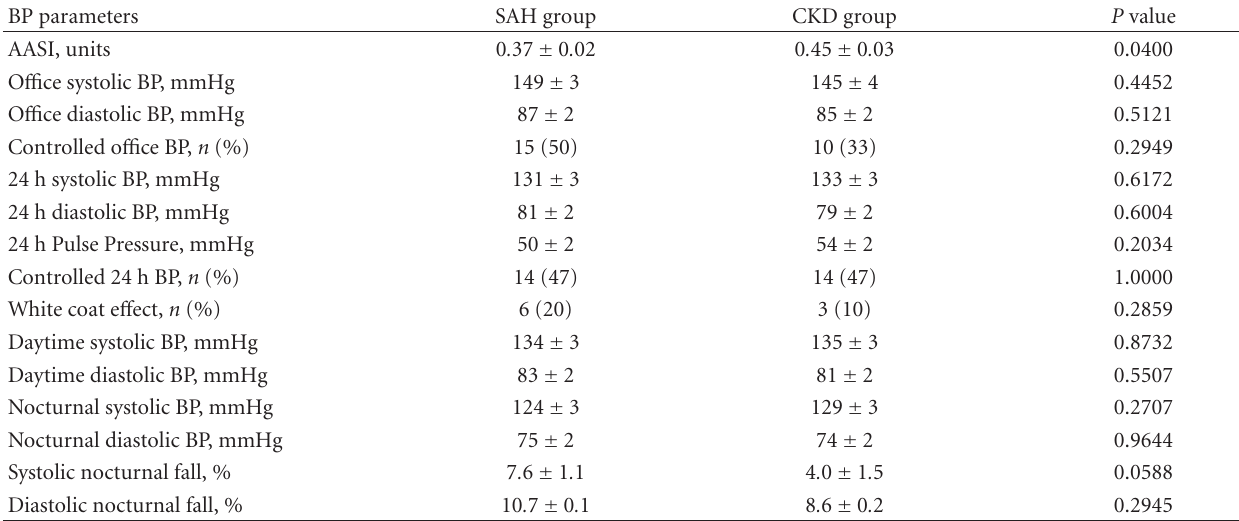
Table 2: O ffi ce and ambulatory blood pressure parameters of hypertensive patients with normal and impaired renal function. BP